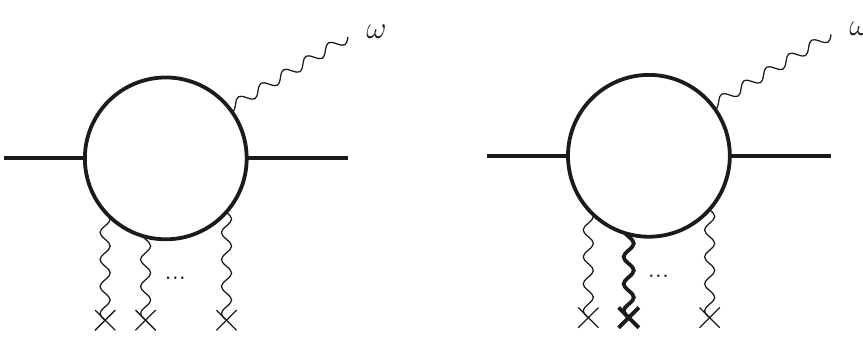
Figure 3 . A sketch of the (cid:12)rst two orders in the modi(cid:12)ed opacity expansion. Left: the zeroth order where only multiple soft scatterings are accounted for (thin wavy vertical lines). Right: The NLO contribution, where one hard scattering is included (thick wavy line) while multiple soft scatterings are resummed to all